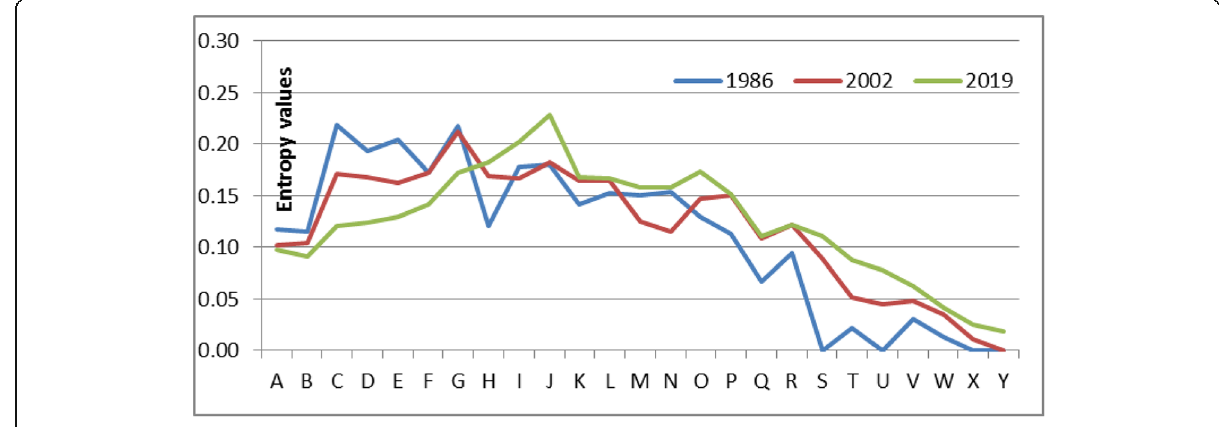
Fig. 7 Distance from the town center and zonal entropy values in each concentric ring